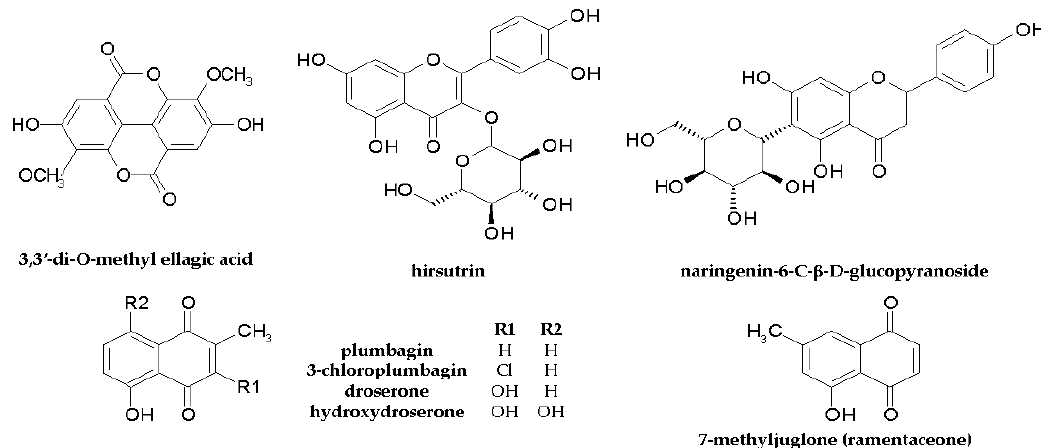
Figure 2. Chemical structure of components with antibacterial and antifungal activity found in Nepenthales. in